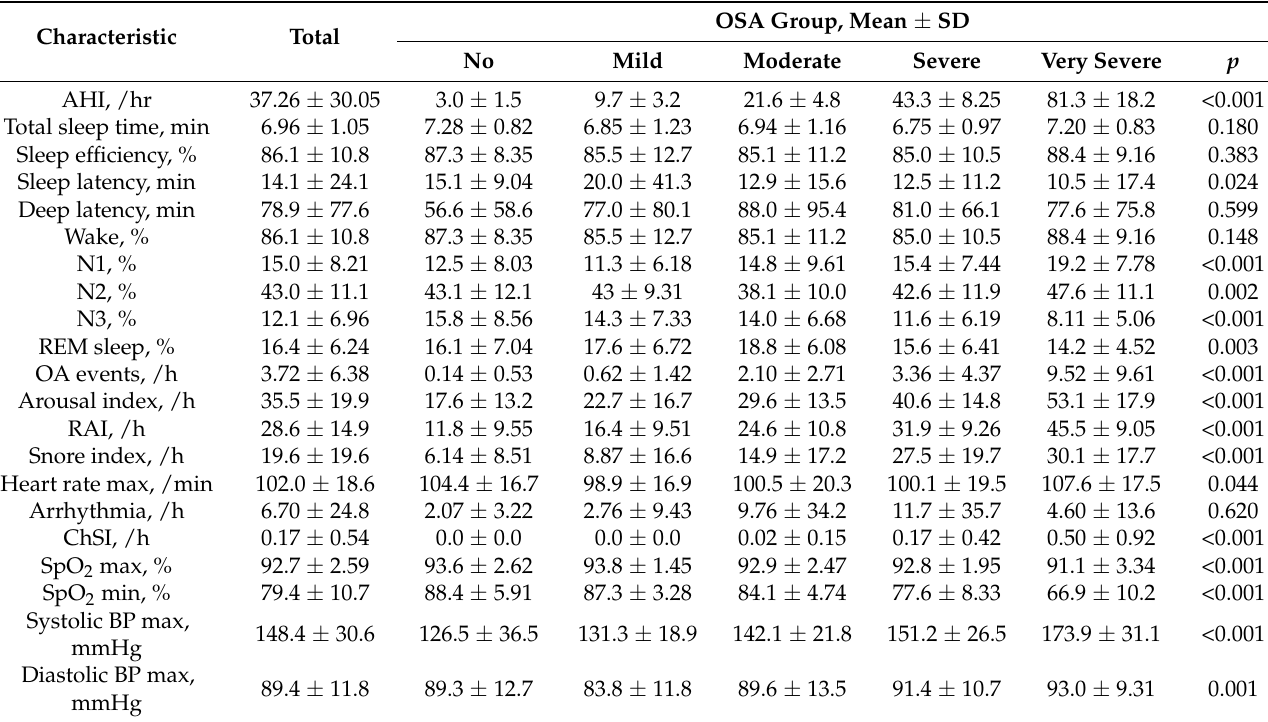
Table 4. Polysomnography characteristics of patients with different severity of